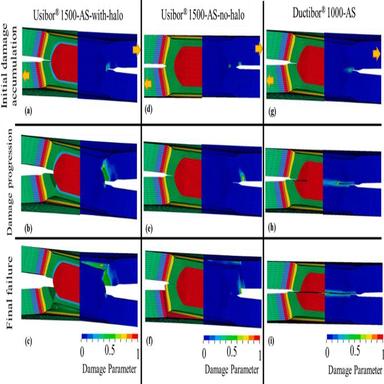
Failure simulation results for spot welds under shear load showing the location of failure and damage progression for (a), (b) and (c) Usibor® 1500-AS-with-halo, (d), (e) and (f) Usibor® 1500-AS-no-halo, and (g), (h) and (i) Ductibor® 1000-AS spot welds. Loading direction is shown by orange arrows. (For interpretation of the references to colour in this figure legend, the reader is referred to the web version of this article.)